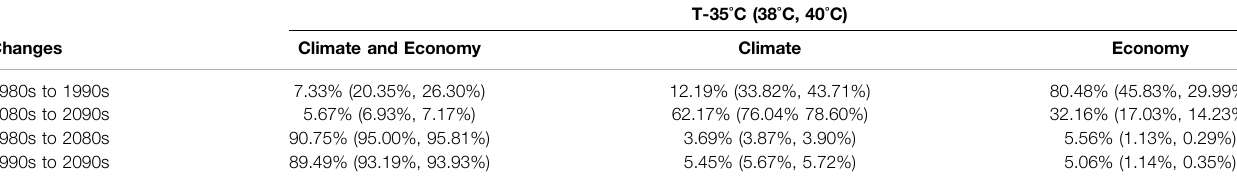
TABLE 2 | Analysis of factors affecting changes in economy exposure to extremely high temperature in Southern